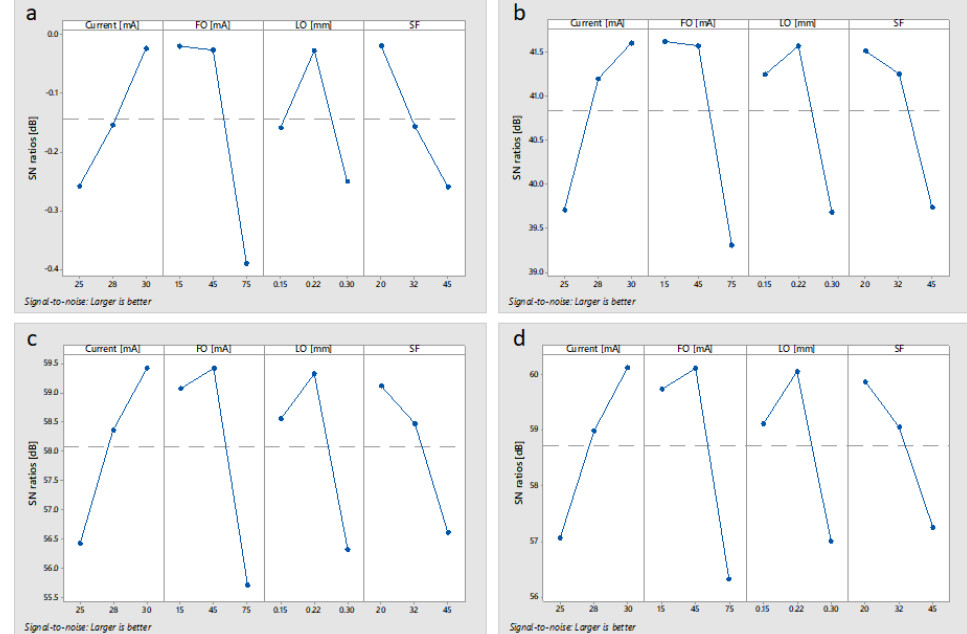
Figure 8. Effect of process parameters on density ( a ), Young’s modulus ( b ), yield strength ( c ), and UTS ( d ).